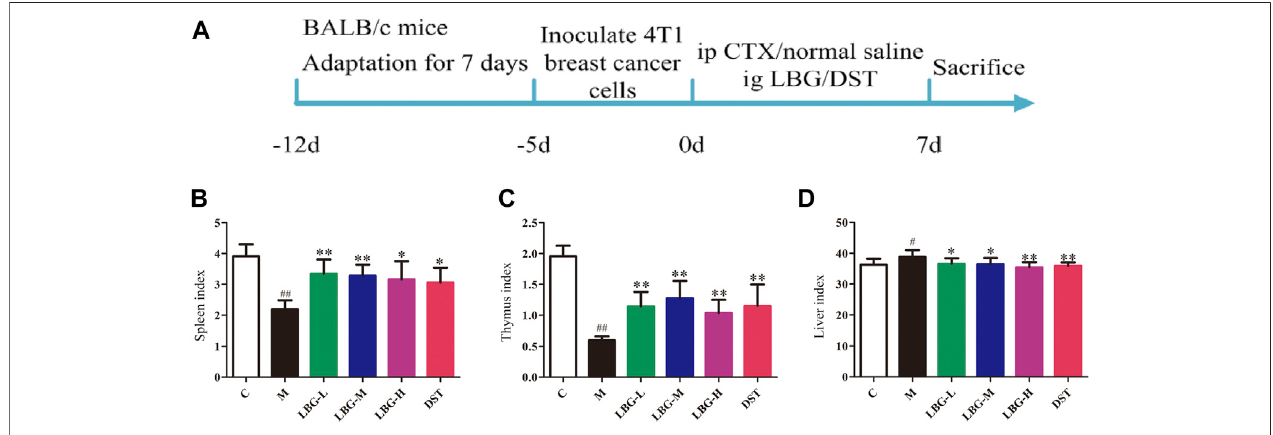
FIGURE 1 | Animal modeling flow chart and the effects of LBG on organ indexes ( n (cid:2) 8). (A) Animal modeling fl ow chart. (B) Spleen index. (C) Thymus index. (D) Liver index. Data are expressed as mean ± SD. # p < 0.05 vs. C group; ## p < 0.01 vs. C group; * p < 0.05 vs. M group; ** p < 0.01 vs. M group.